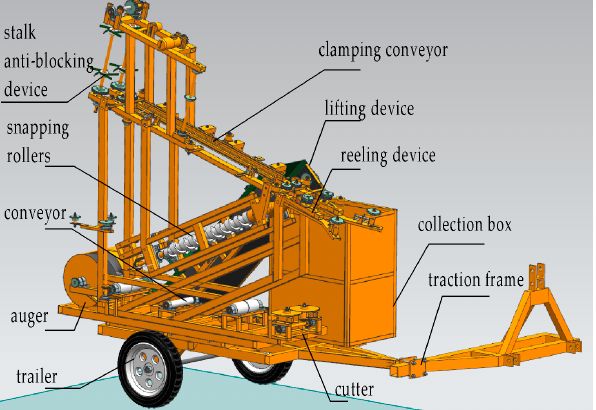
Figure 3. Structure of bionic reverse picking header.